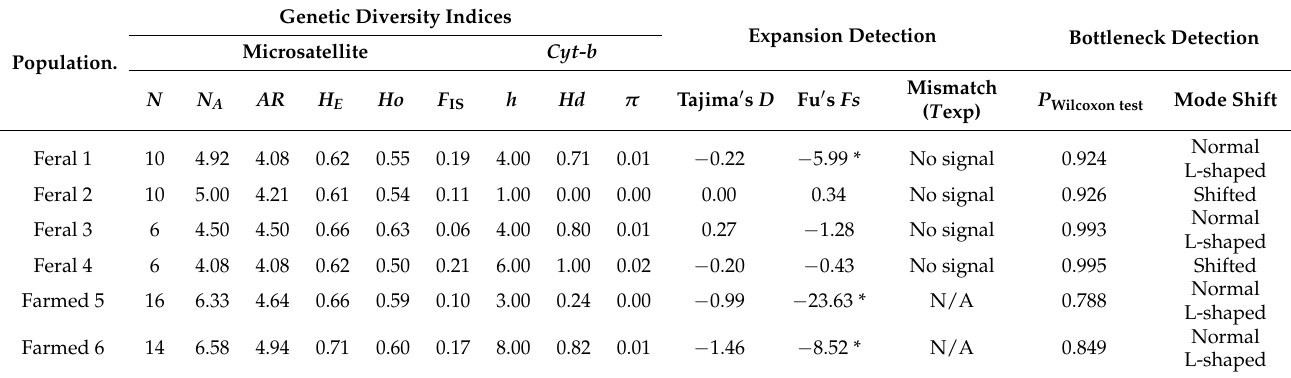
Table 2. Genetic diversity indices and demographic characteristics for farmed and feral American mink in China.